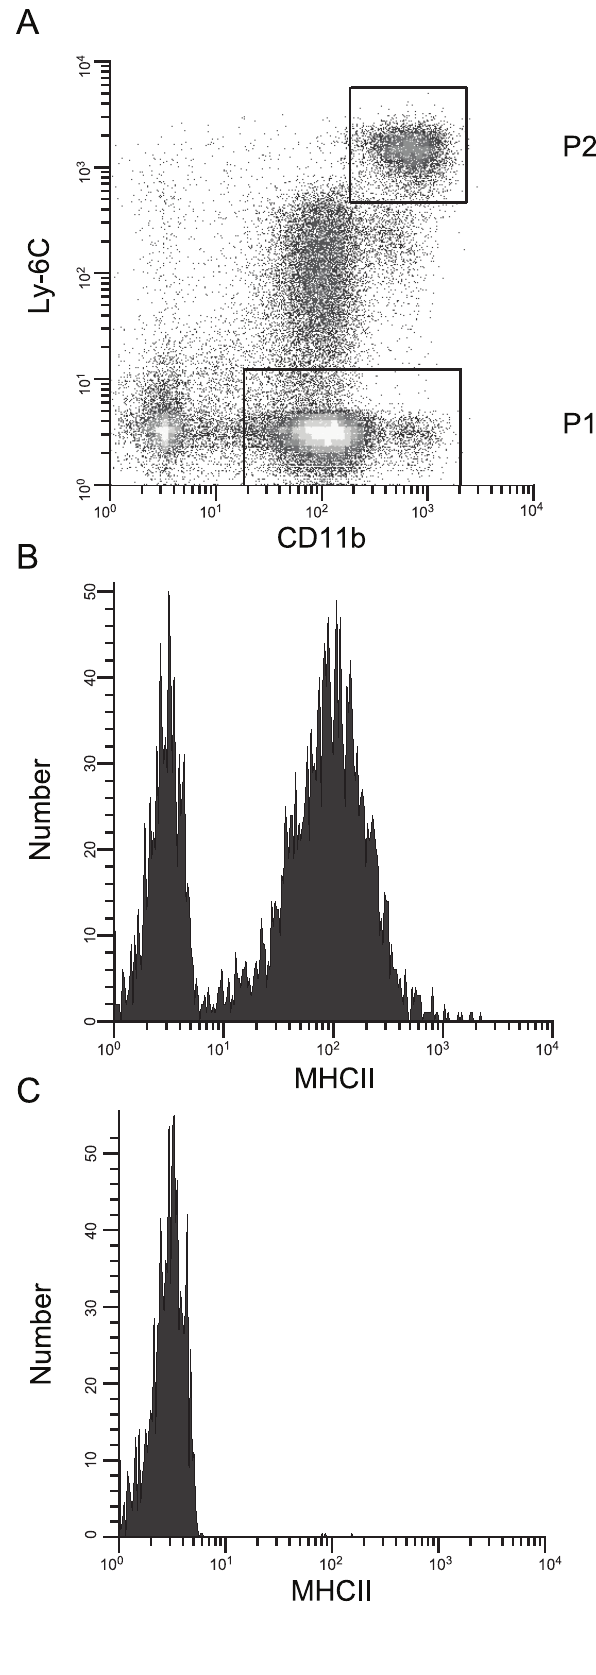
Figure 5. CD11b + cell populations in RAG 2 / 2 mice. A, Flow cytometric analysis of CD11b and Ly-6C expression by splenocytes from RAG-1 2 / 2 mice. Gates encompassing the two main cell populations are labeled P1 and P2. B, MHC class II expression by cells contained within gate P1. C, MHC class II expression by cells contained within gate